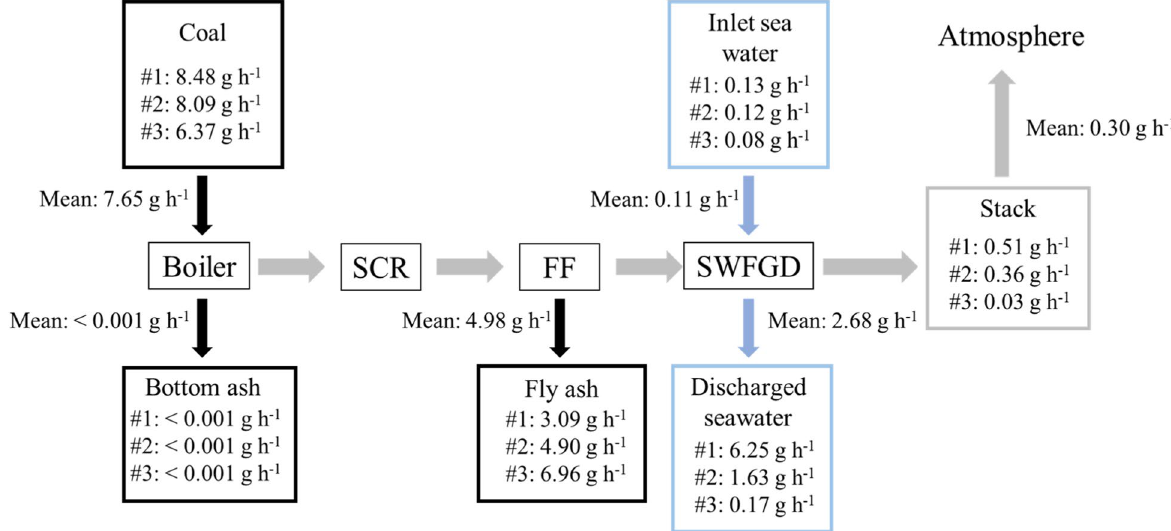
Fig. 4 The mass flow of mercury in coal-fired power